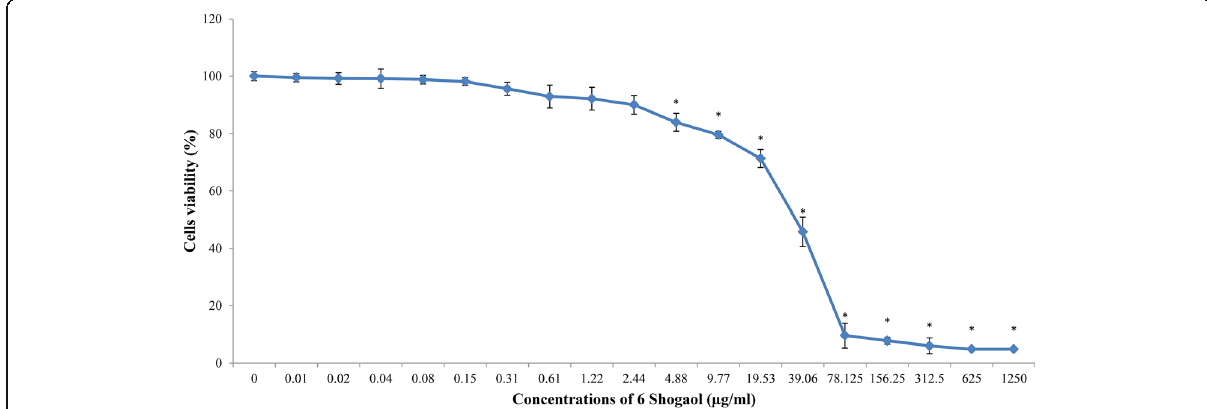
Fig. 3 Cytotoxic effect of 6-shogaol on PC-12 cells. Cells were incubated with 6-shogaol at increasing concentrations up to 1250 μ g/ml for 48 h. The mean absorbance obtained using complete F-12 K medium with cells only was designated as 100%. Data were expressed as means ± SD from three independent experiments carried out in triplicates. * p < 0.05 compared to the respective